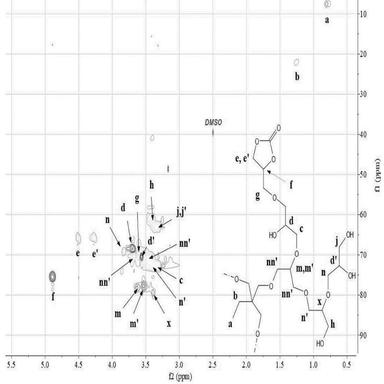
1 H–13C HSQC-DEPT NMR spectrum (500 MHz, DMSO‑d6) of hyperbranched polyglycerol containing five-membered cyclic carbonate groups.